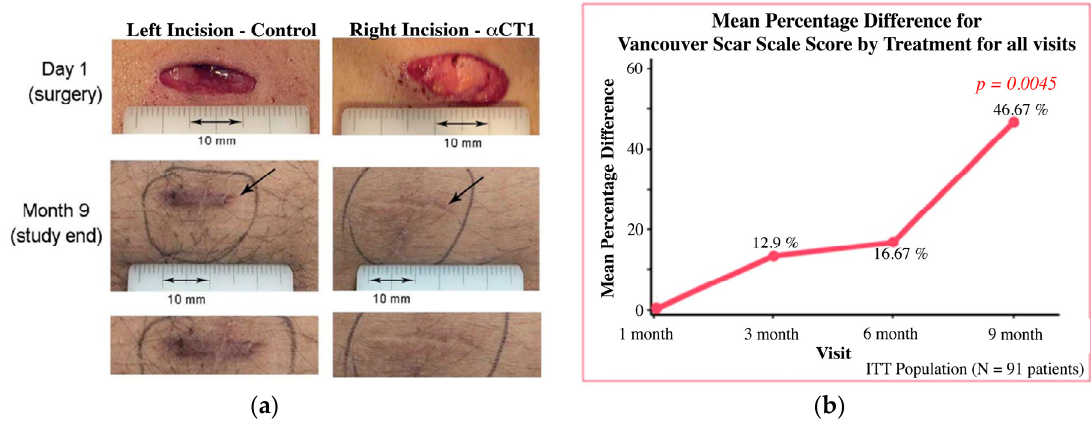
Figure 3. ( a ) Photographs of a single patient’s α CT1 and control treated wounds immediately after surgery and at the study end point of nine months; ( b ) Mean percentage difference between treatment and control scar scores for the Phase II scar appearance clinical trials [35].